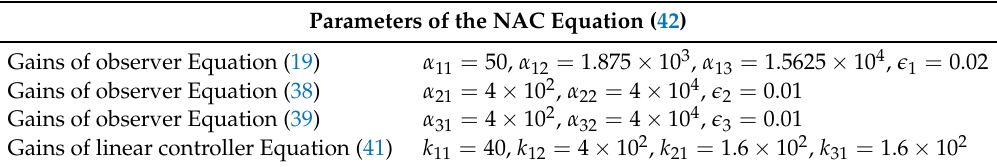
Table 2. Parameters of Pitch control approach for simulation